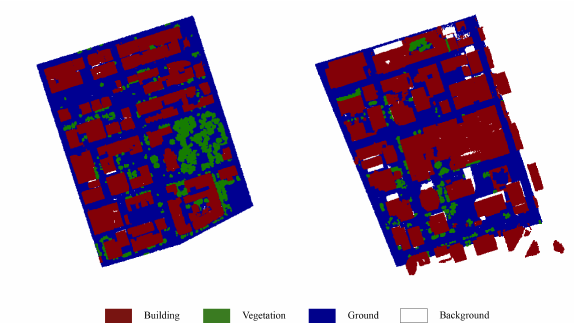
Figure 4. Classification results of two areas in Toronto